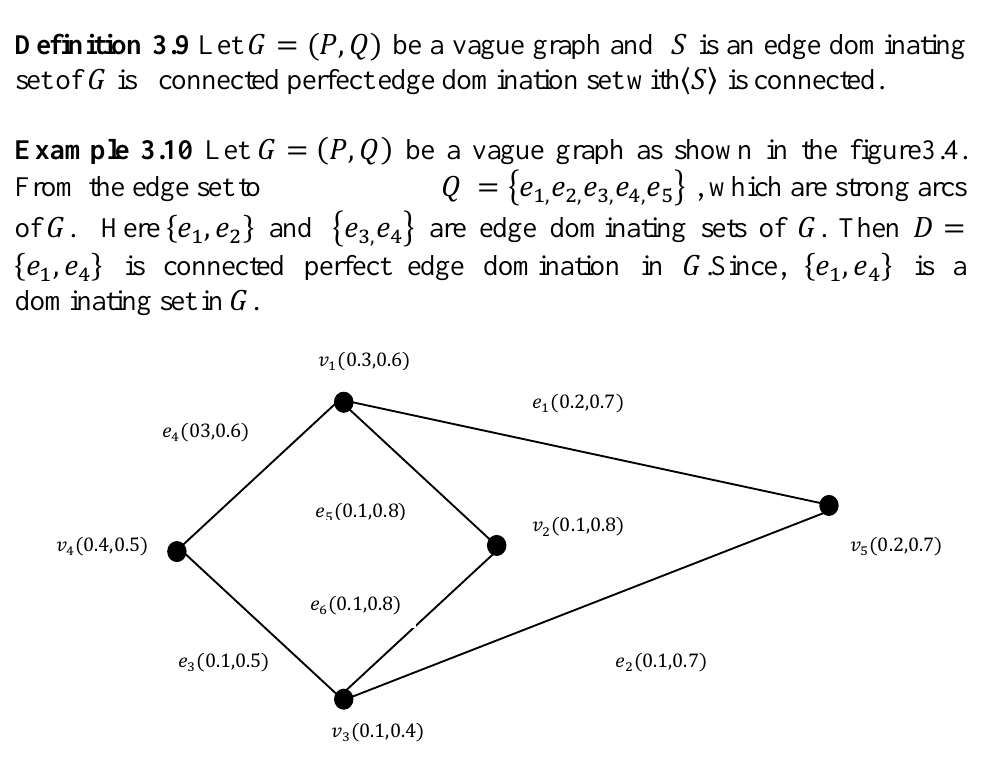
Figure 3.4: Connected perfect edge